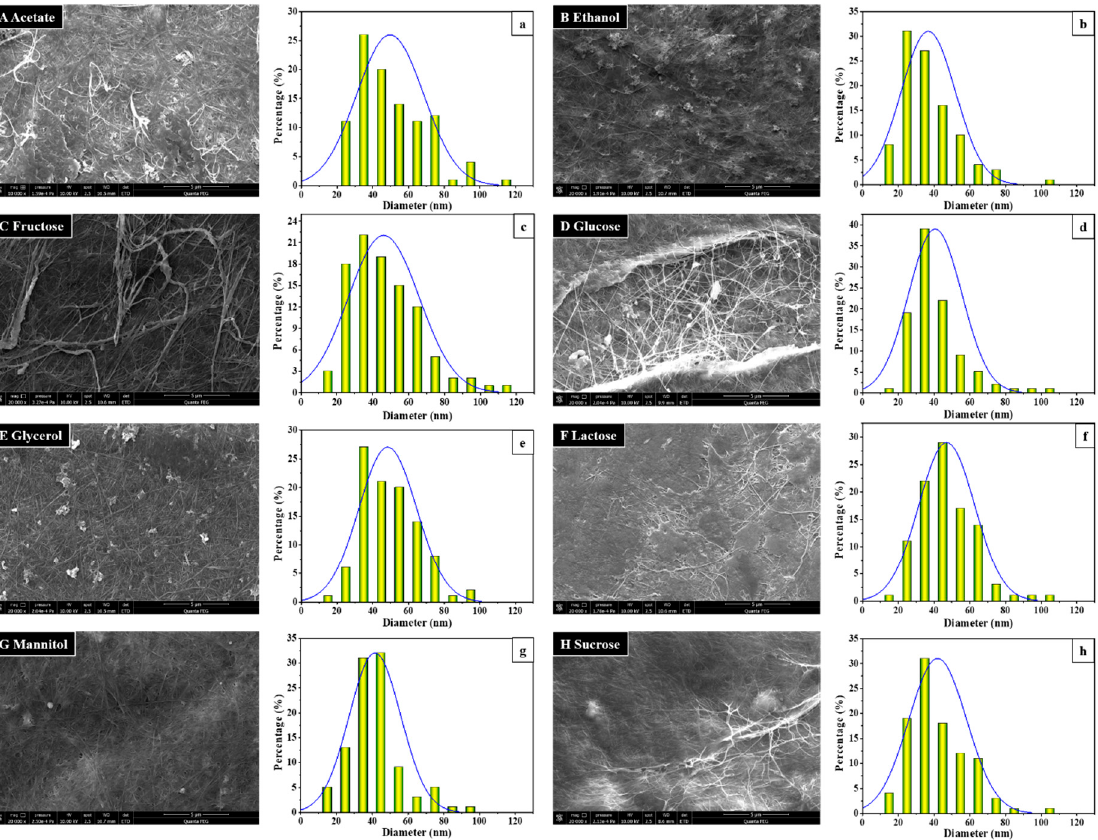
Figure 2. Morphology ( A – H ) and diameter distribution ( a – h ) of the BC produced by Komagataeibacter sp. W1 grown in the media spiked with different carbon sources. While the BC morphology was observed with scanning electron microscopy (SEM) with a spot of 3.0, high voltage of 15 KeV, and magnification of 20,000×, the diameter calculation was performed on Nano Measurer 1.2 by calculating 100 nanofibrils randomly on the SEM images.